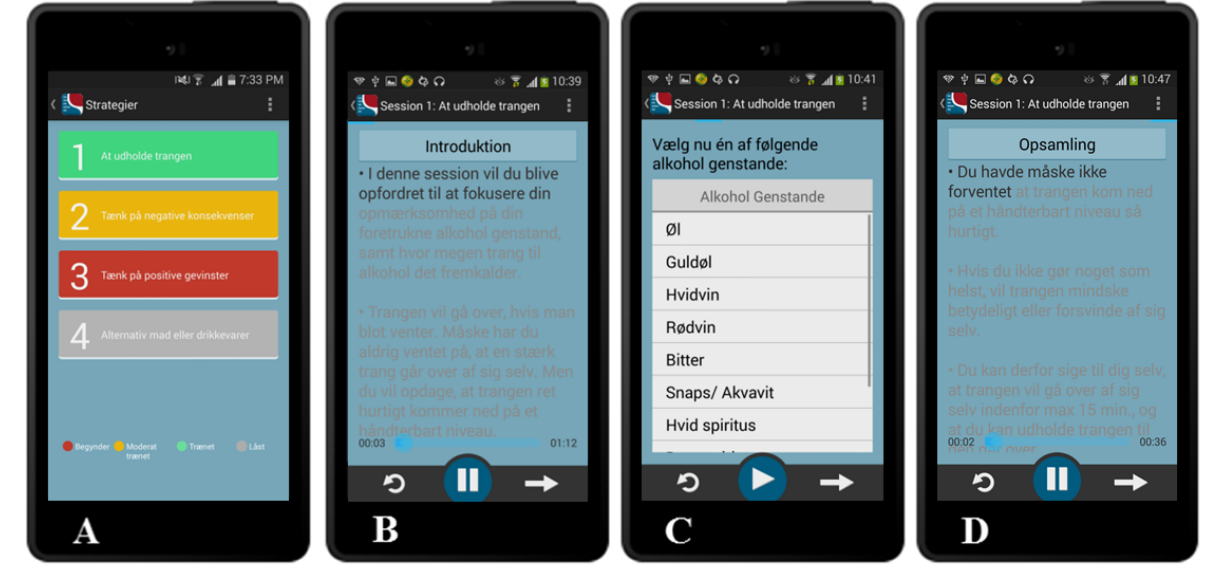
Figure 3. Strategies (part A); session 1: waiting it out, introduction to the USCS (part B), selection of exposure video (part C), and session 1: waiting it out, summary of the USCS (part D). USCS: urge-specific coping